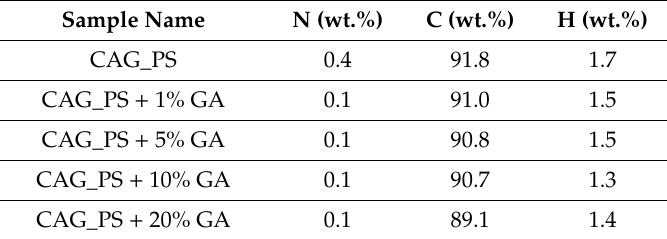
Table 1. Elemental analysis results of pristine (CAG_PS) and modified (CAG_PS + GA) samples.